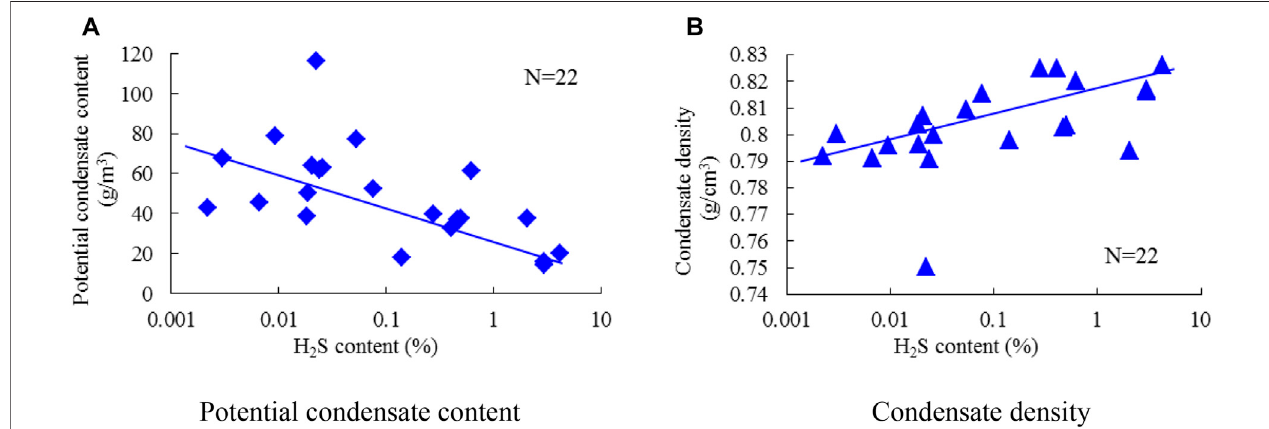
FIGURE 8 | Relationship between condensate property and H 2 S content. (A) Potential condensate content. (B) Condensate density.